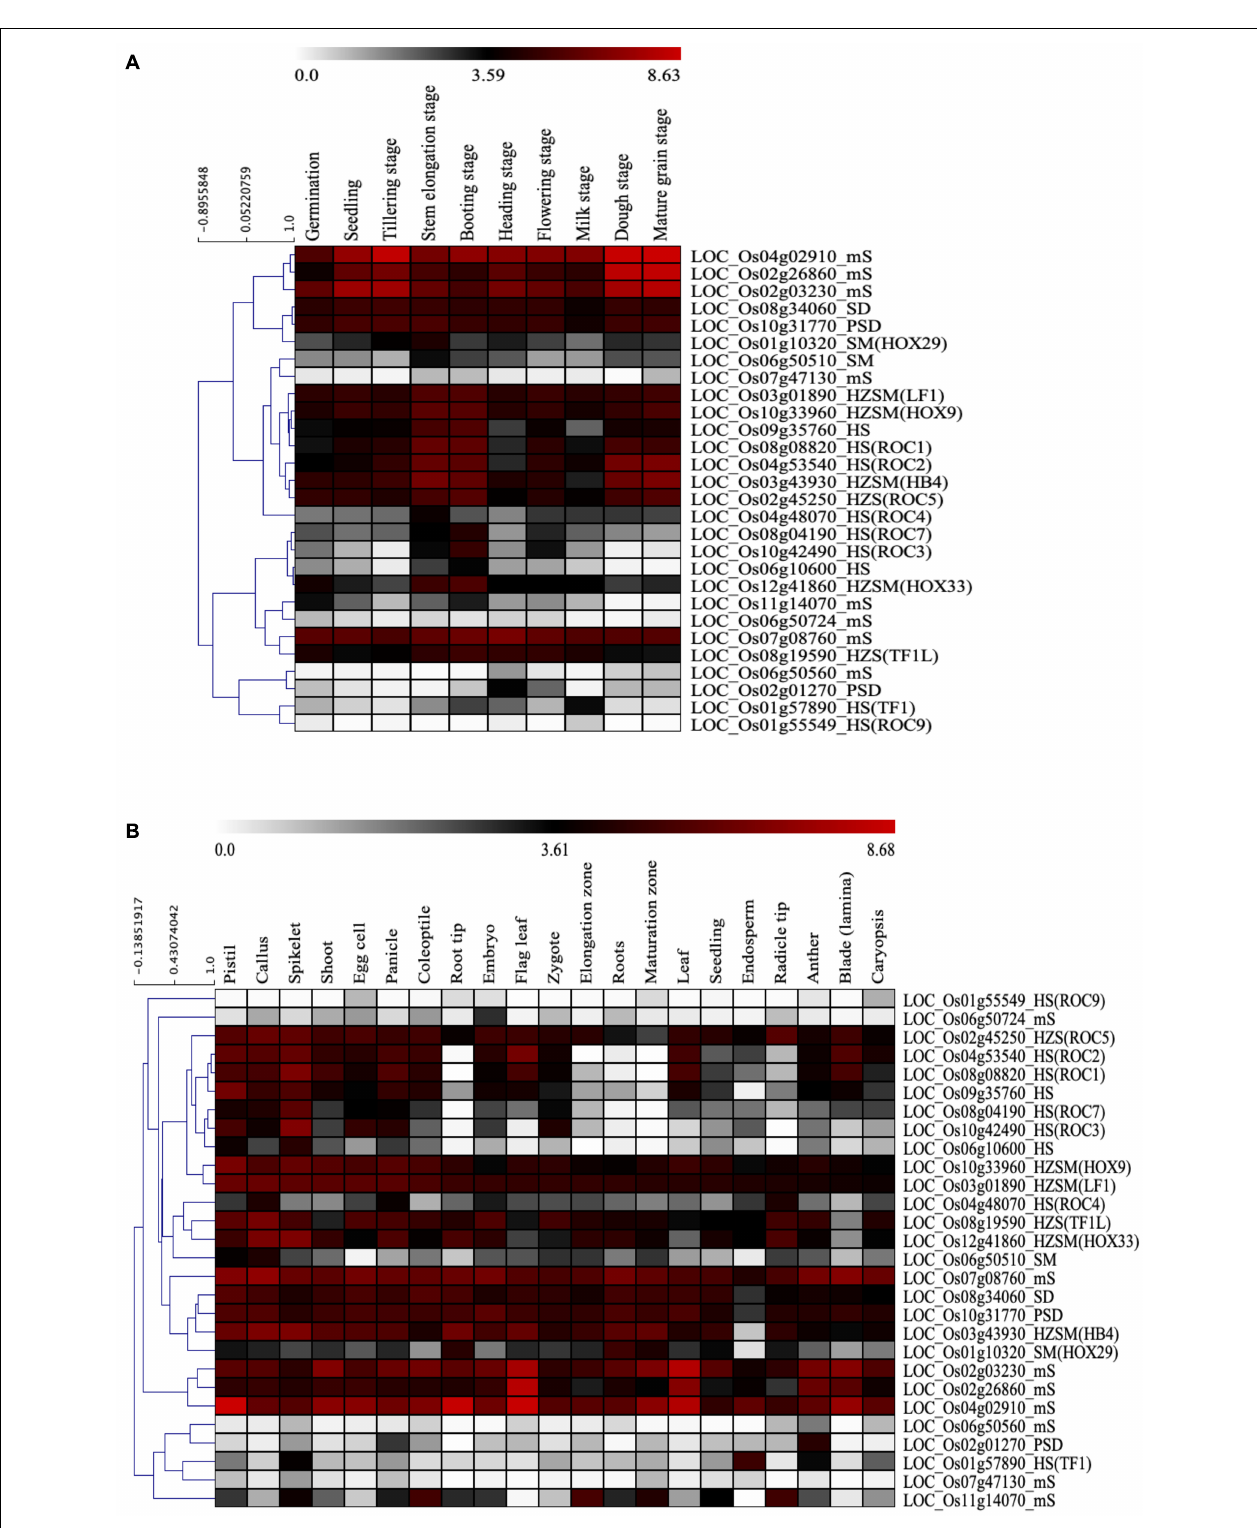
FIGURE 7 | In silico expression study of 28 START genes in Oryza sativa var. japonica . (A) Hierarchical gene expression pattern of START genes at different developmental stages. (B) Hierarchical gene expression pattern of START genes in various anatomical parts.